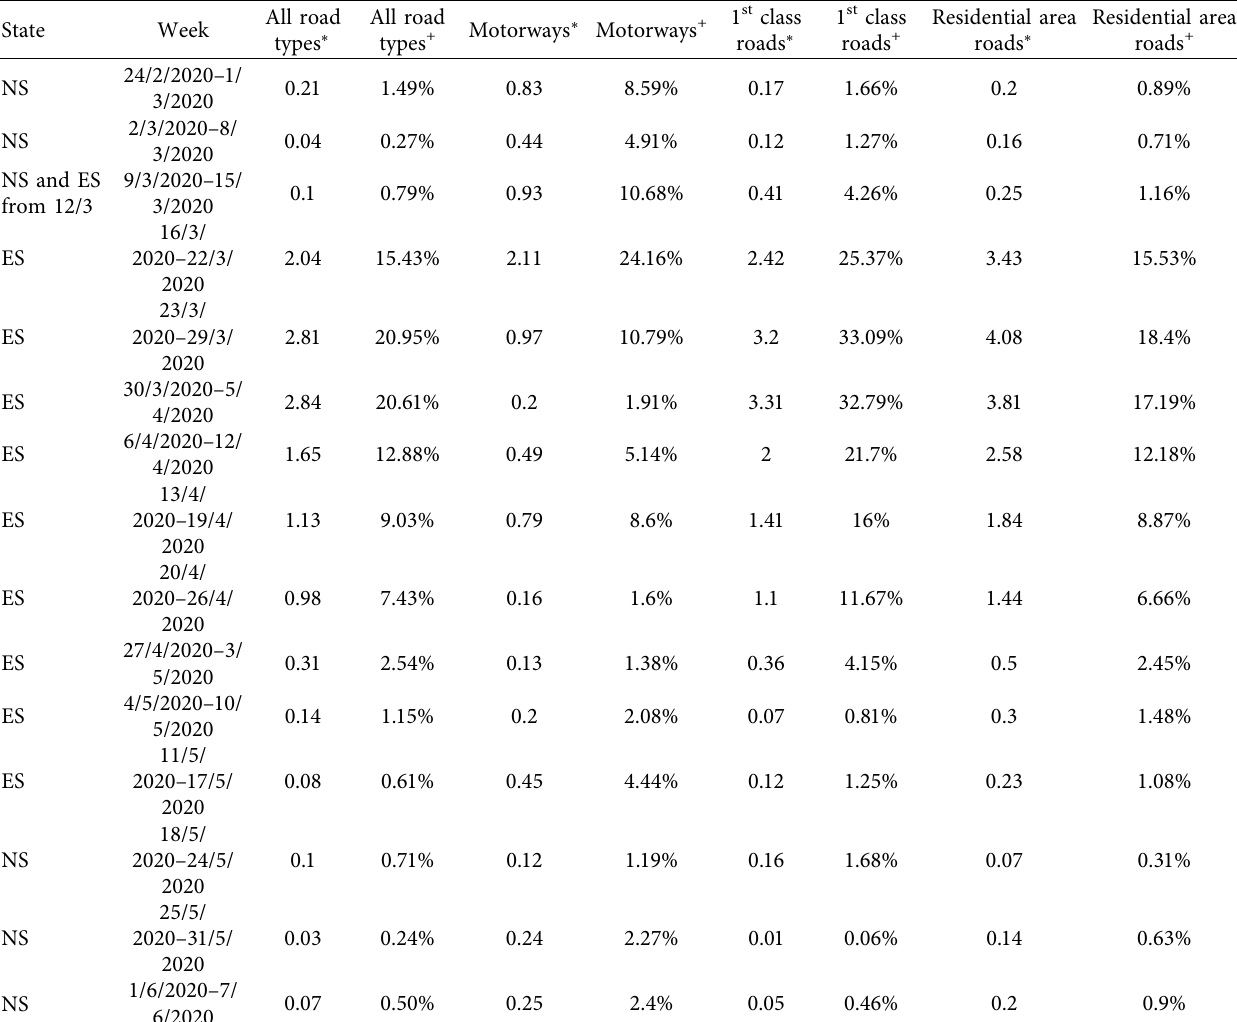
Table 2: Basic overview for all road types and three selected road types: motorways, 1 st class roads, and residential area roads. All State Week